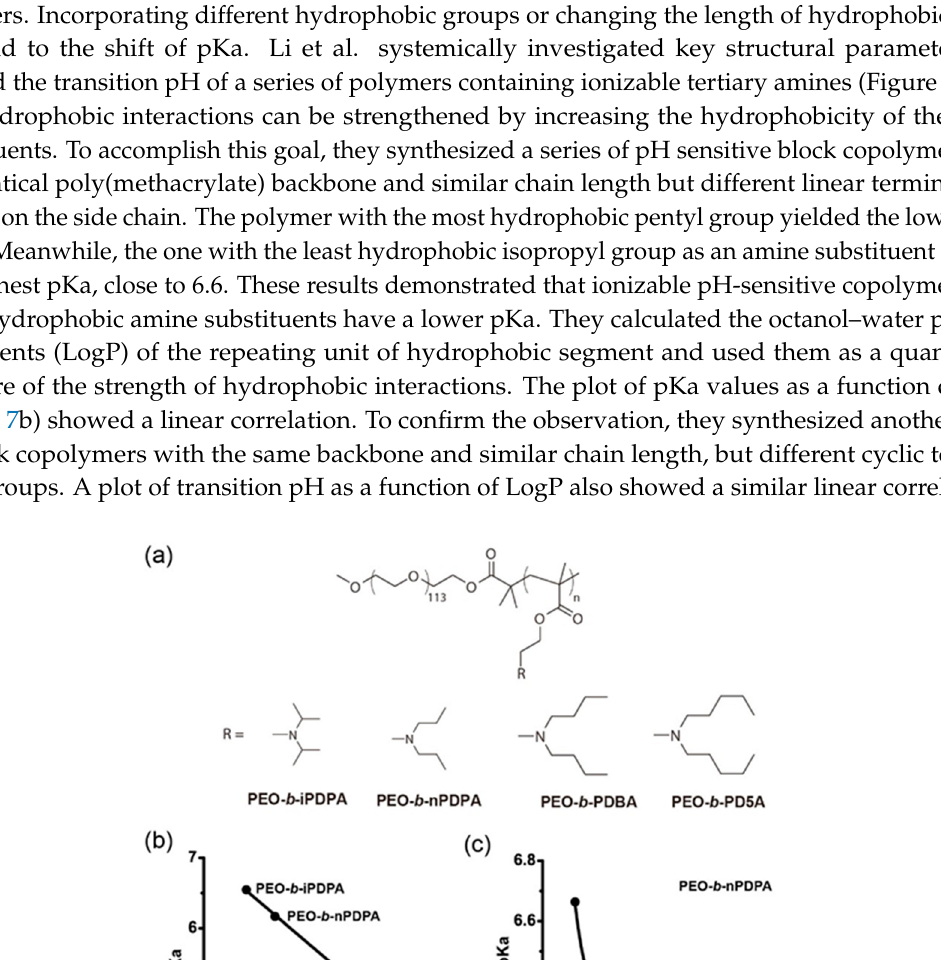
Molecules 2019 , 24 , x 8 of 24 target effect and lowering toxicity [70]. One major consideration in the design of pH-responsive nanomaterials is choosing polymers with pKa values matching the desired pH range. The acidity of gastrointestinal track is drastically different from that of blood [71]. Intracellular compartments such as mitochondria, endosomes, and lysosomes also have slightly different pH values [72]. Even the level of acidosis shows small variation among different types of tumors [6]. Therefore, a key consideration in the design of tumor-targeted pH-responsive polymers is to ensure the polymers are able to differentiate acidic tumor microenvironment from surrounding normal tissues. The variation in the potency of diverse anti-tumor therapeutics also requires tunable release kinetics of payloads. Reversible protonation of pH responsive polymers leads to the change of the hydrodynamic volume, chain conformation, water solubility and maybe supramolecular self-assembly. Ionization